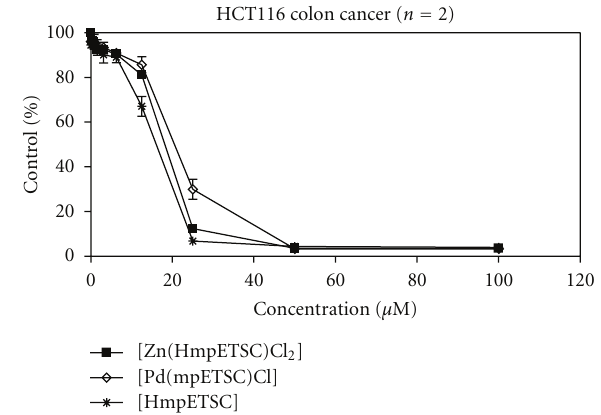
Figure 6: Antineoplastic activity in human colon carcinoma HCT116 cells by a growth inhibition SRB assay after 96-hour treat- ment of HmpETSC, [Zn(HmpETSC)Cl 2 ], and [Pd(mpETSC)Cl].